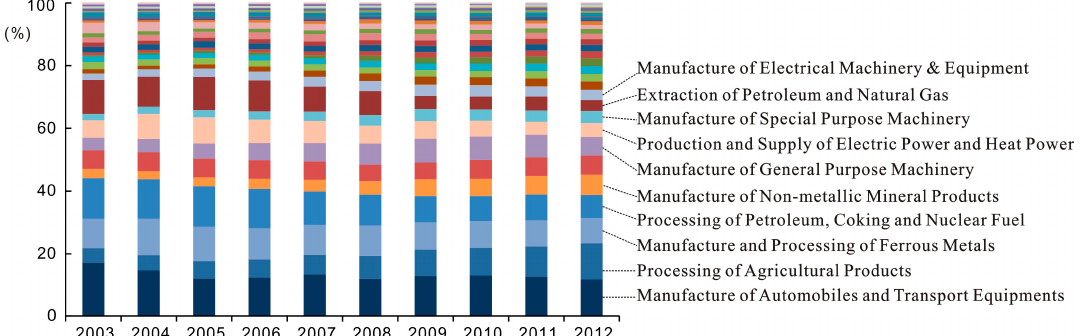
Figure 5. The structural shrift of industrial sector 2003–2012. Note: The subsectors with significant proportion change are labelled.